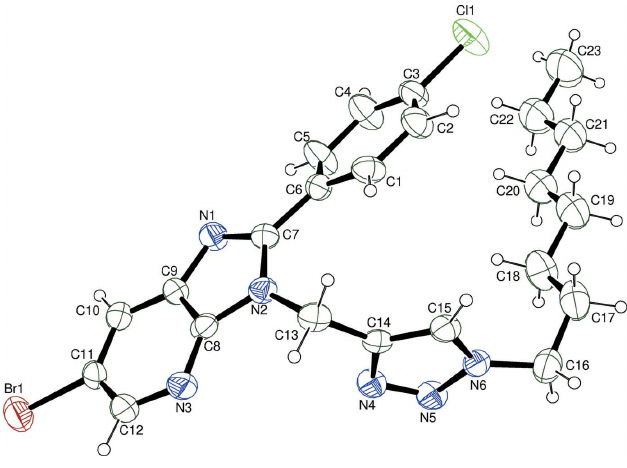
Figure 1 The molecular structure of the title compound with displacement ellipsoids drawn at the 50% probability level.